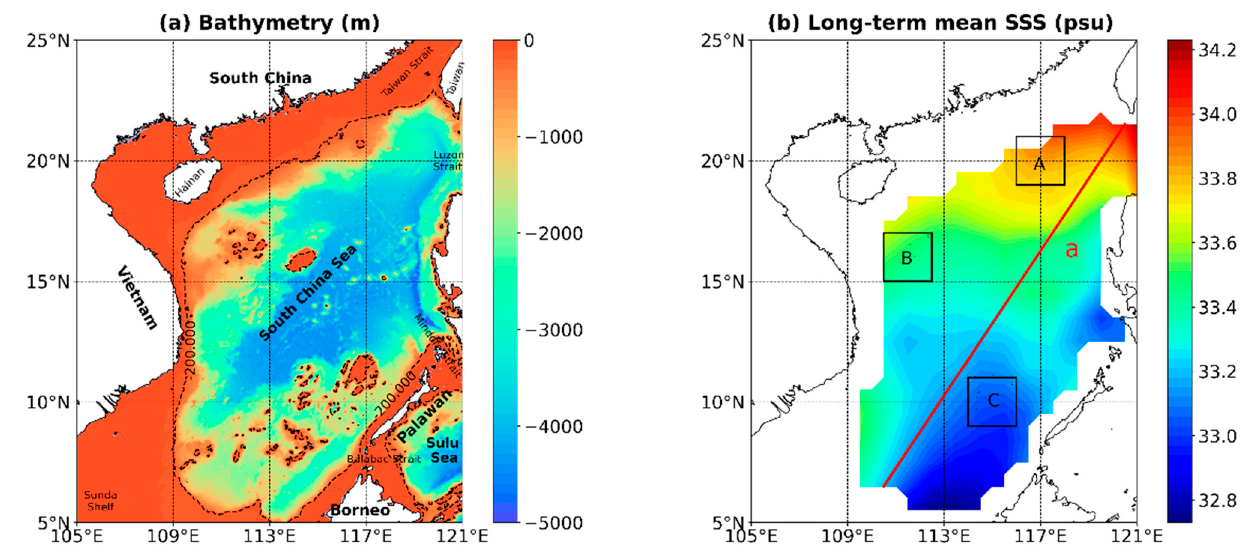
Figure 1. ( a ) Bathymetry (m) and geography of the SCS and ( b ) spatial distribution of long-term mean SSS (from January 2010 to December 2019) from Argo in the SCS. The three black boxes denote the study regions used in this study. The red line represents the location of transect used in this study.